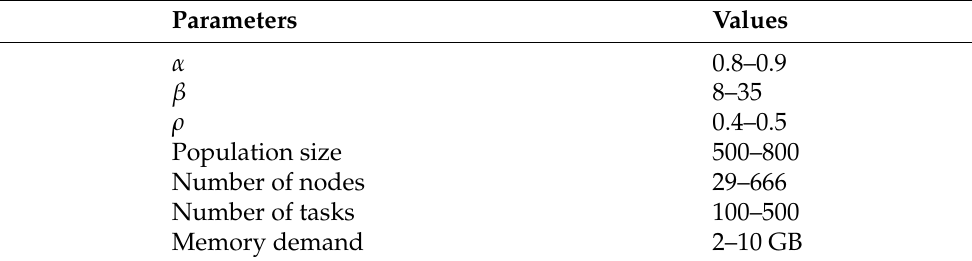
Table 2. Parameters settings of test